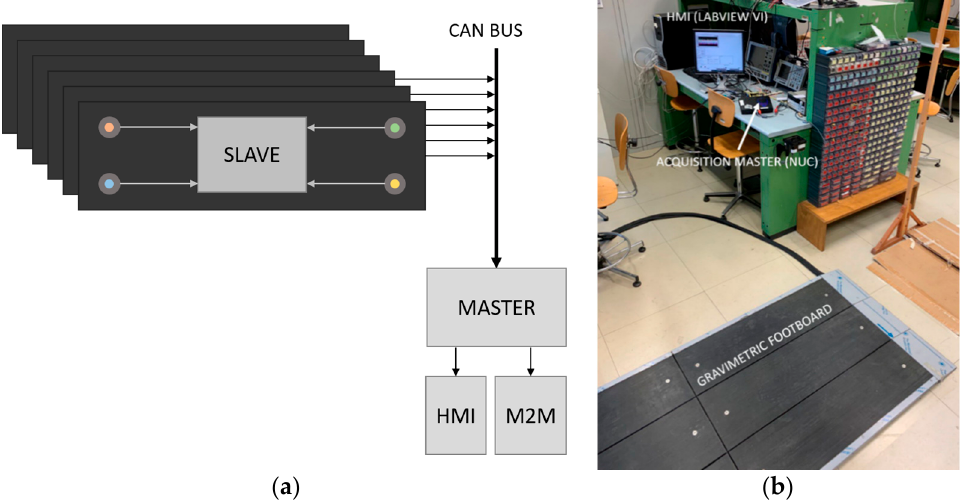
Figure 15. ( a ) Block diagram of the complete gravimetric system architecture. ( b ) Complete gravimetric system set-up.